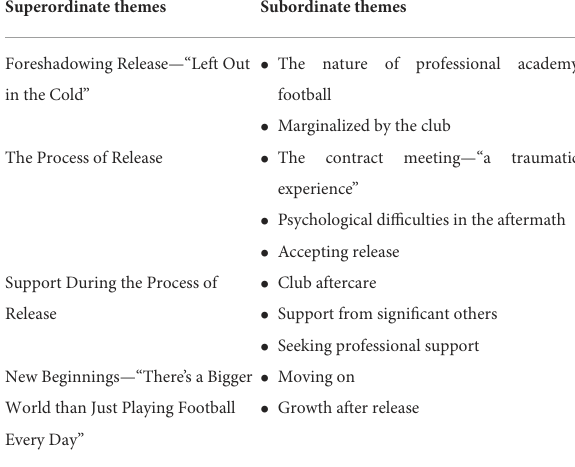
TABLE 1 Table of themes identified from the